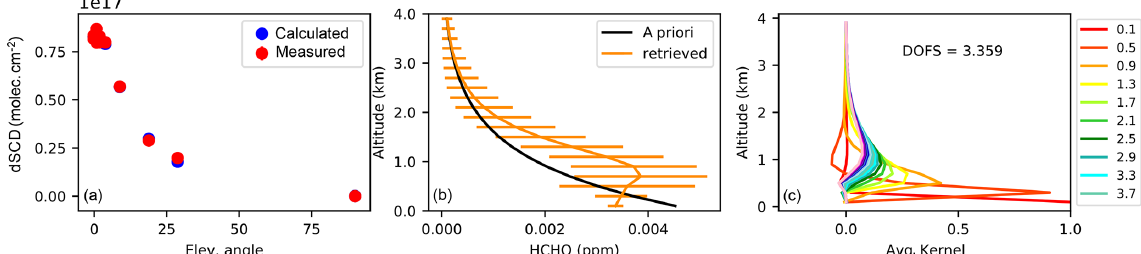
Figure 3. Example HEIPRO retrieval from Broadmeadows on 13 December 2017 at 14:00LT. Panel (a) shows the retrieved–measured dSCD comparison, panel (b) shows the retrieved and a priori profiles and panel (c) shows the averaging kernels for this retrieval.